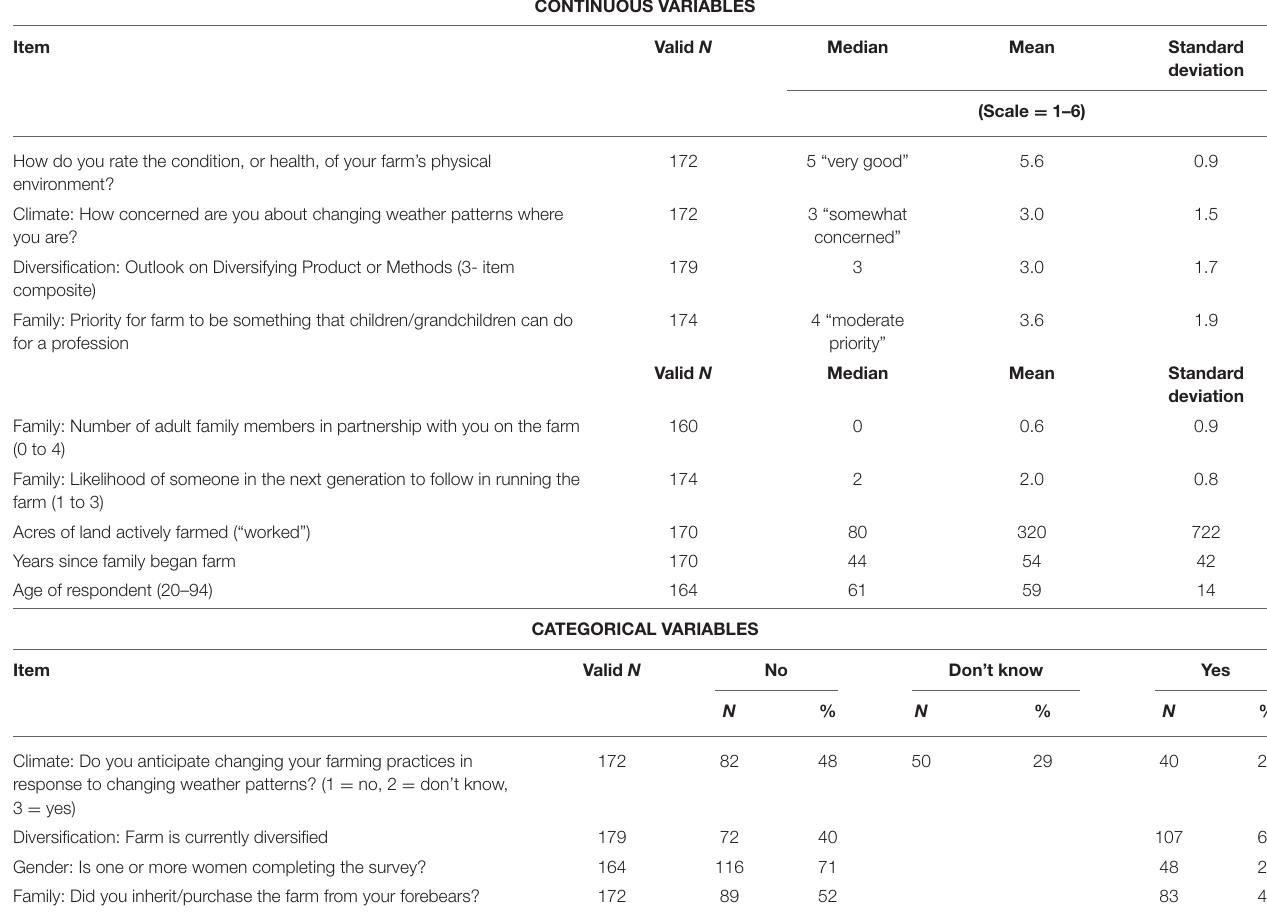
TABLE 2 | Descriptive statistics: Farmer survey respondent characteristics and perspectives on implications of climate change for agricultural